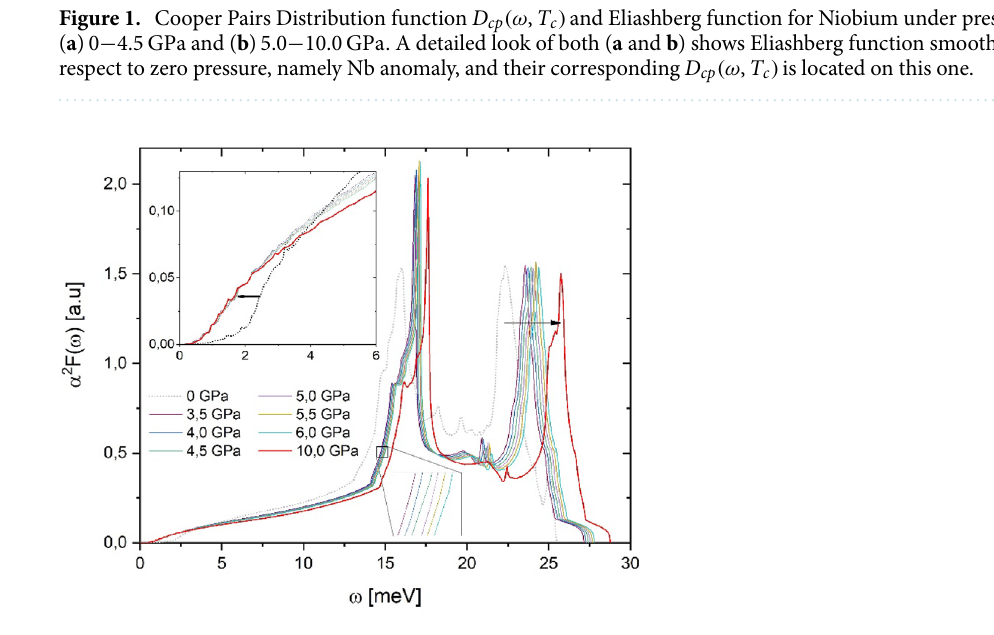
Figure 2. Eliashberg function ( 0 − 10GPa ) for Niobium. Right arrow signs α 2 F (ω) hardening. Soothing interval of α 2 F (ω) (left arrow) is